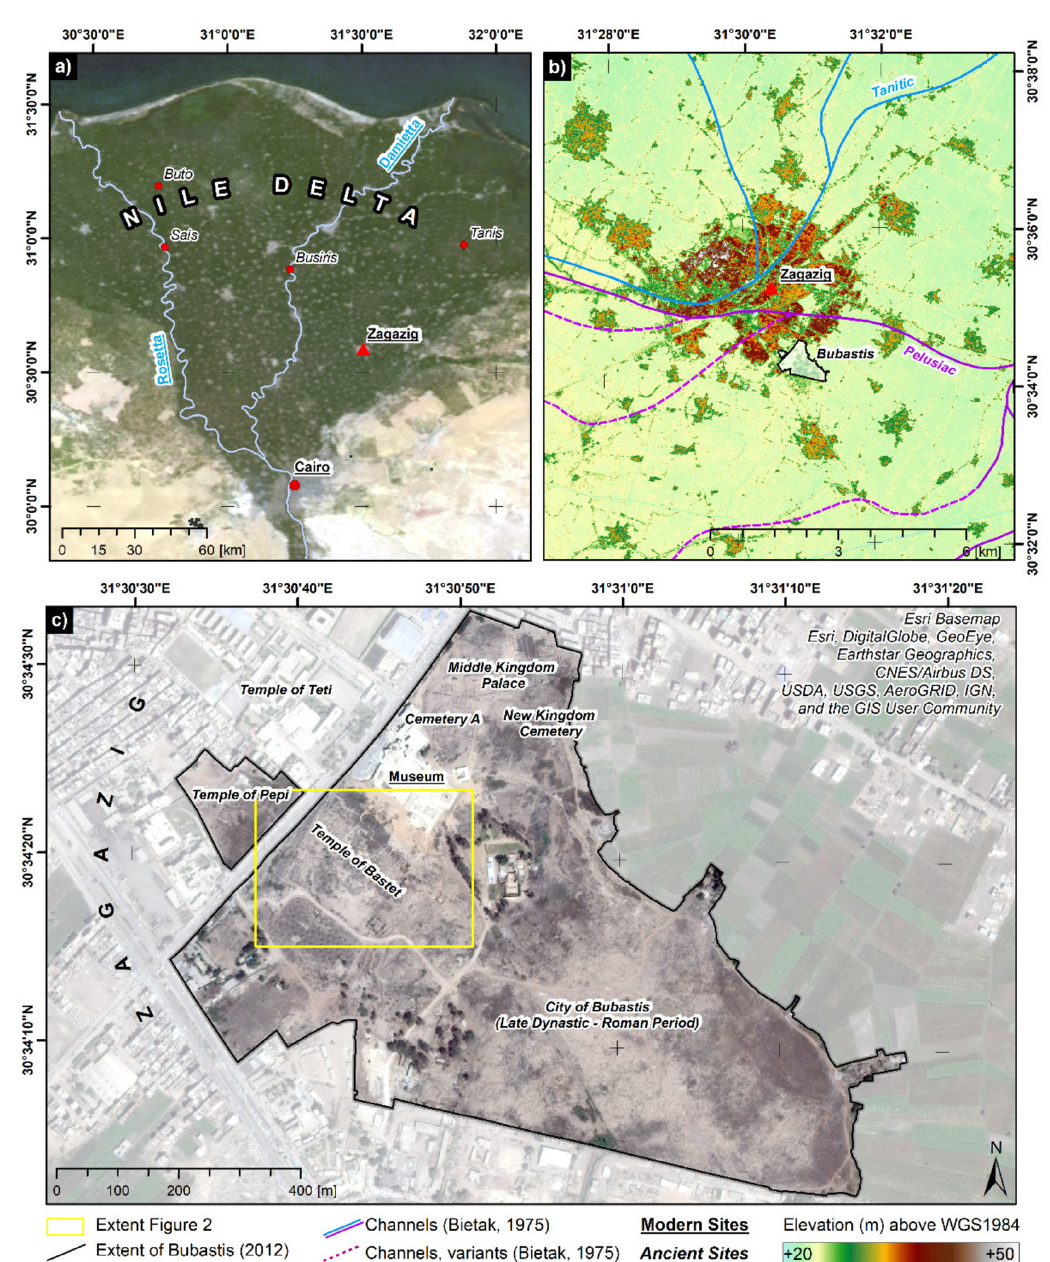
Figure 1. ( a ) Location of the modern town Zagazig in the Nile Delta, Egypt (Database: Terra MODIS True Color Corrected Reflectance from August 2020, © earthdata.nasa.gov); ( b ) Location and extent of ancient Bubastis in Zagazig (Database: Digital Elevation model of the TanDEM-X Mission, ©DLR, 2012); ( c ) Current extent of Bubastis with ancient and modern features (Database: © Esri